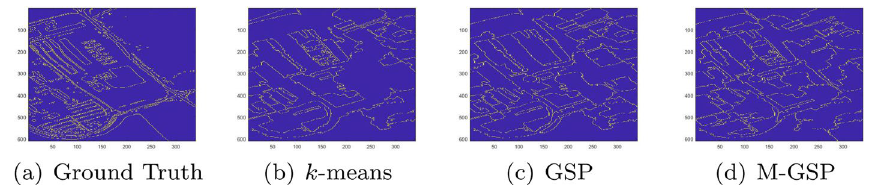
Fig. 14 Boundaries in Pavia University